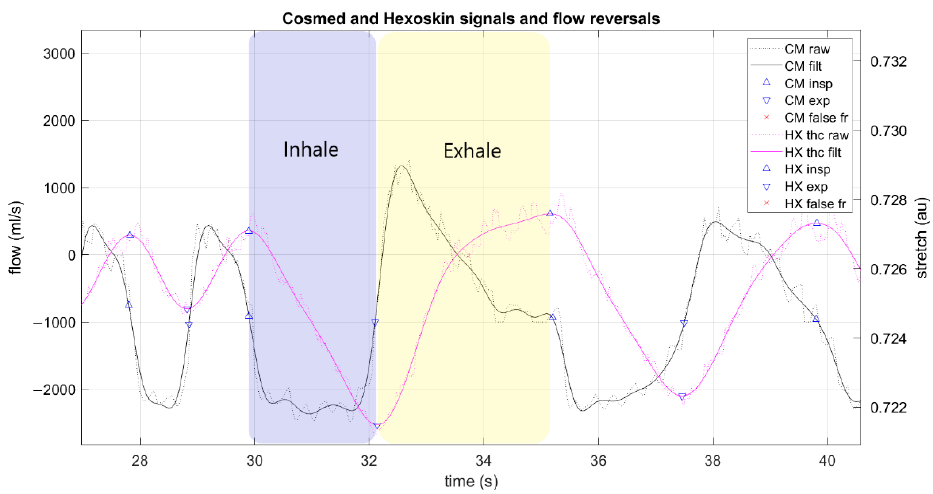
Figure 4. Example Cosmed and Hexoskin signals and detected flow reversals from one trial. No false flow reversals were detected in this signal example. Annotated “exhale” and “inhale” breath phases are approximate representations of breath phase determination by the algorithm. CM: Cosmed, HX: Hexoskin, filt: filtered, insp: inspiration, exp: expiration, au: arbitrary units; fr: flow reversal.